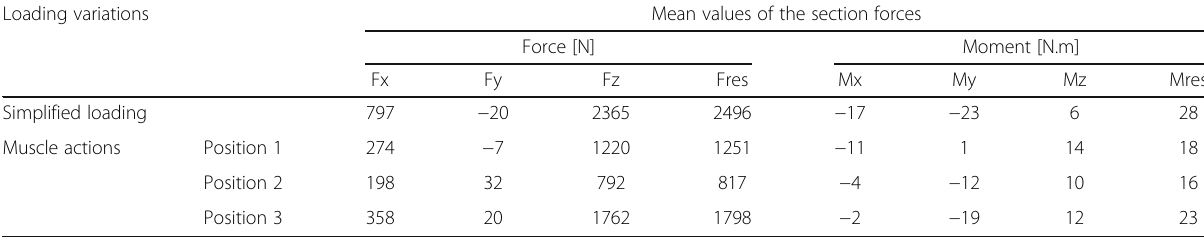
lowing the wedge as shown in Fig. 2 -c are given in Table 2 . The forces and the moments were given in the local coordinate system located at the centroid of the cross section. The section forces, due to the muscles, were smaller than those resulting from the applied verti- cal load of 2500 N, which considered as being a Table 2 Comparison of the section forces and moments in the cross section shown in Fig. 2-C. The forces and the moments were given in the local coordinate system located at the centroid of the cross section. Fx, Fy, Fz were the components of the Force; Mx, My, Mz were the components of the Moment. Fres and Mres were the resulting of the force and of the moment respectively Loading variations Mean values of the section forces Force [N] Moment [N.m] Fx Fy Mres Simplified loading Muscle